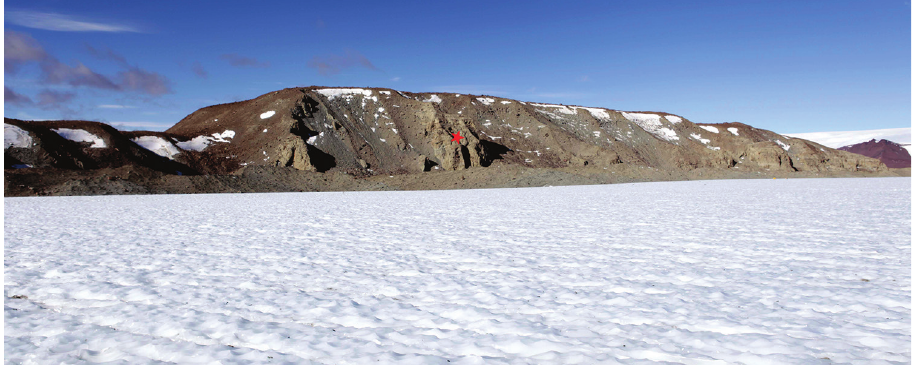
Figure 3. Ancient glacial deposits of the Meyer Desert Formation exposed in the Oliver Bluffs on the flanks of the Beardmore Glacier. The deposits are downthrown along the Koski fault which is marked by the prominent escarpment towards the north end of the bluffs (left on image). The type locality for A. balli sp. n. is at the north end of the bluffs marked by a red star.